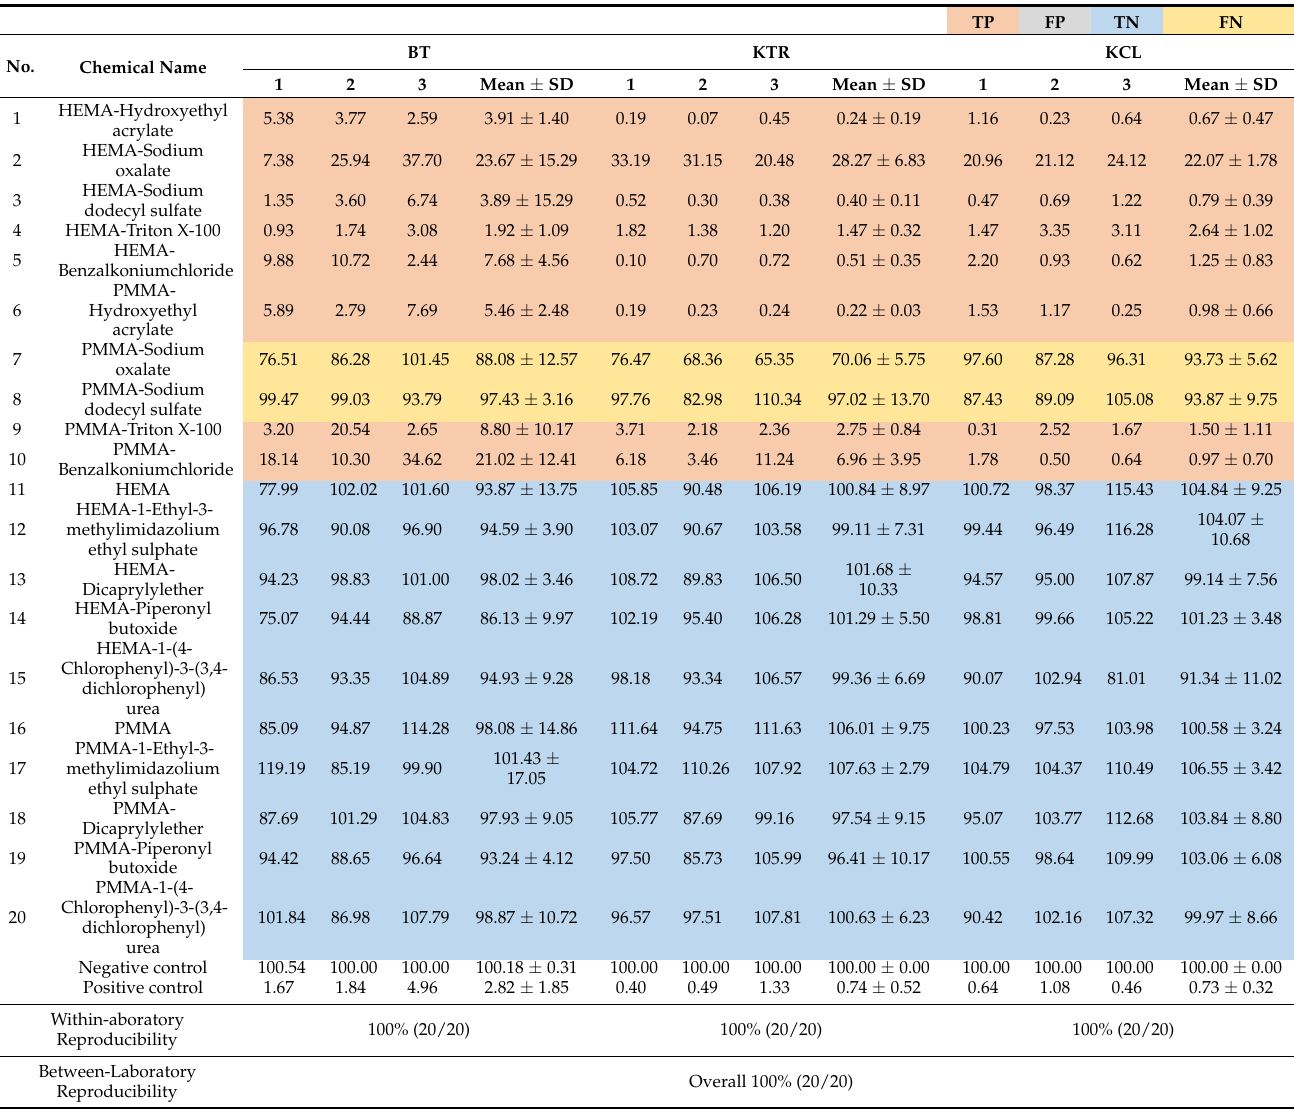
Table 3. Raw data of the results of 3 replicates on 20 test substances by each of the 3 laboratories using non-polar solvent extraction.